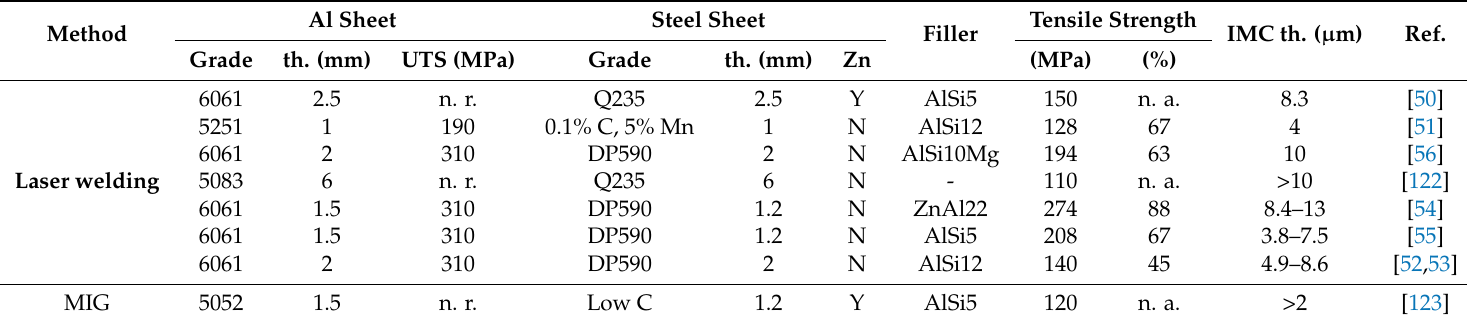
Table 3. Main results of hybrid continuous (linear) butt welding